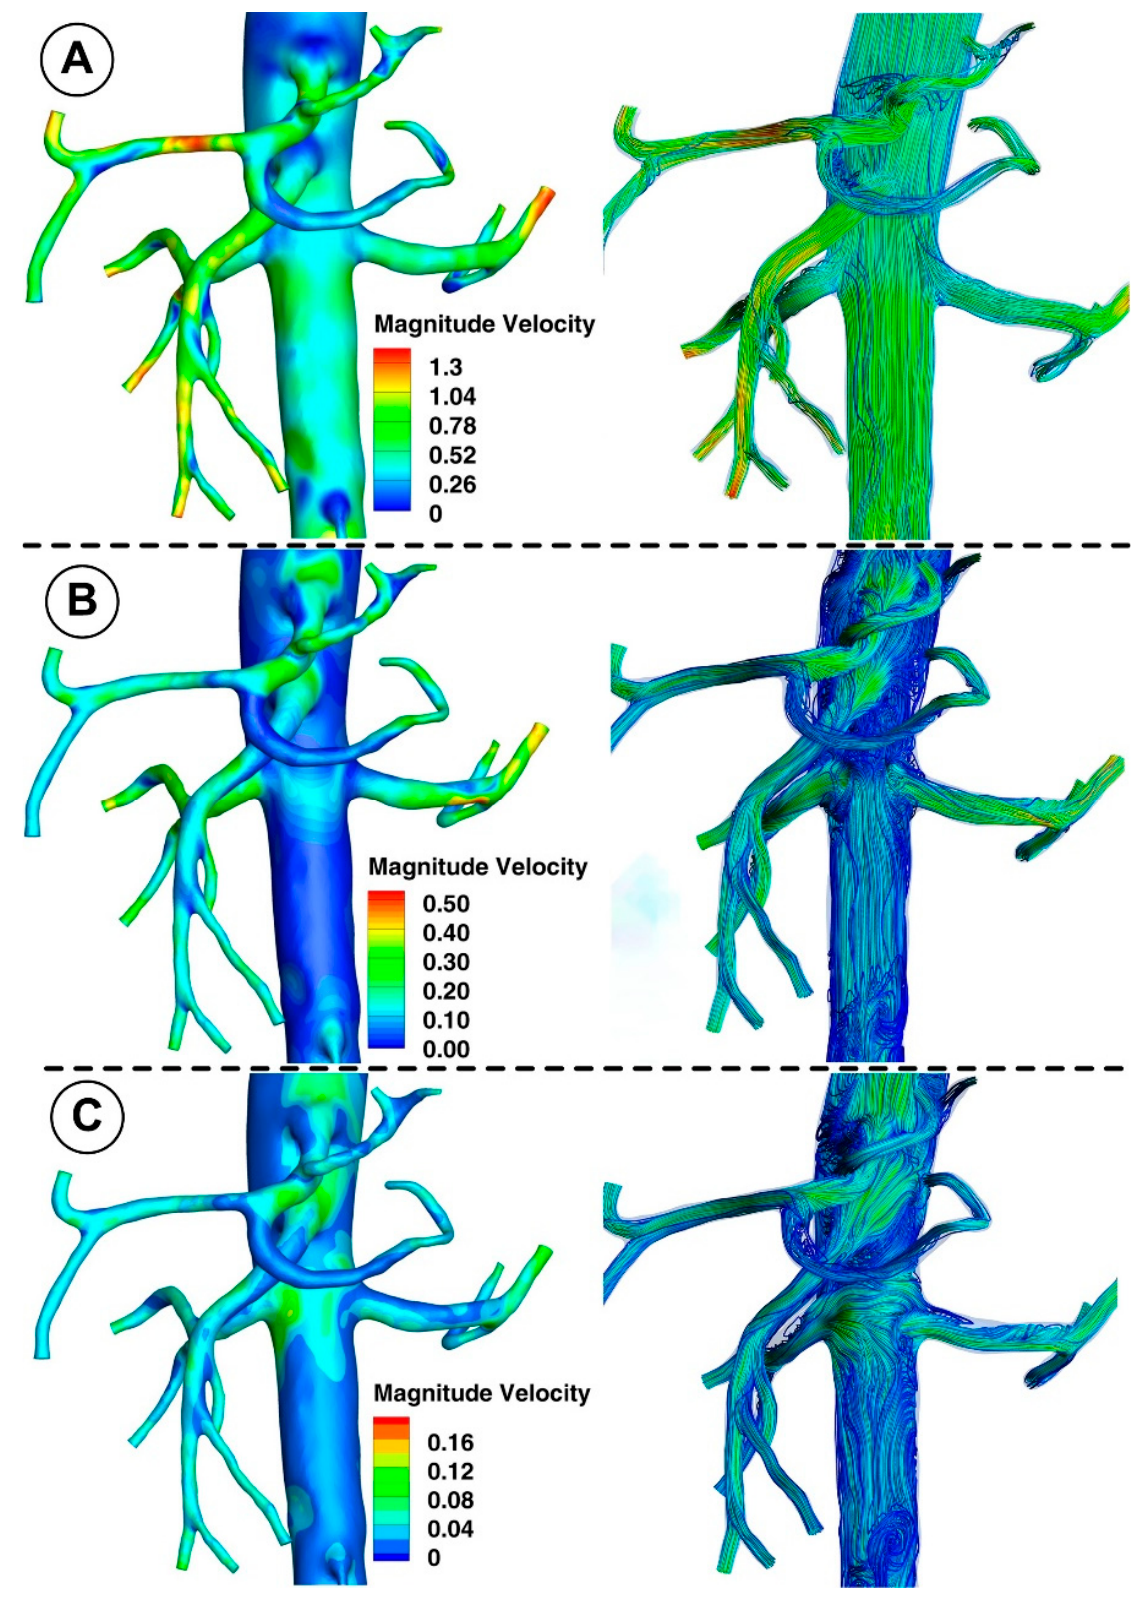
Figure 10. Representative 3D image of a reconstructed artery’s bifurcation segment showing the distribution of WSS and the path line for different time steps corresponding to the investigated cardiac cycle. ( A ) T1 = 0.15 s; ( B ) T2 = 0.45 s; ( C ) T3 = 0.6 s.